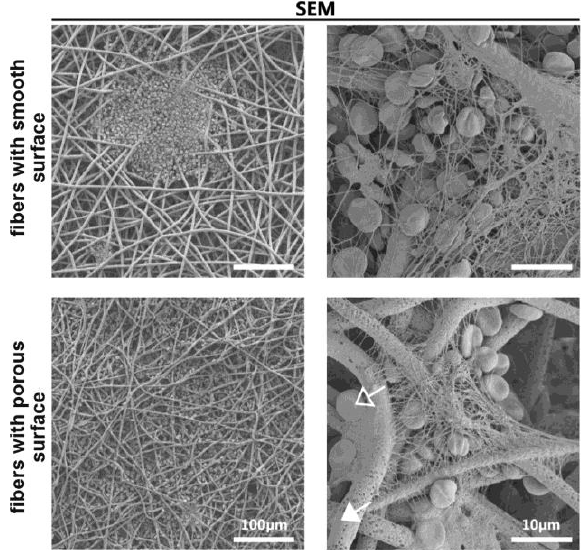
Figure 5. SEM images were obtained after 1 h whole blood incubation on electrospun scaffolds containing fibers with smooth or porous surface (reprinted from Ref. [56]. Copyright © 2018 Biointerphases Inc. Published by the American Vacuum Society.)